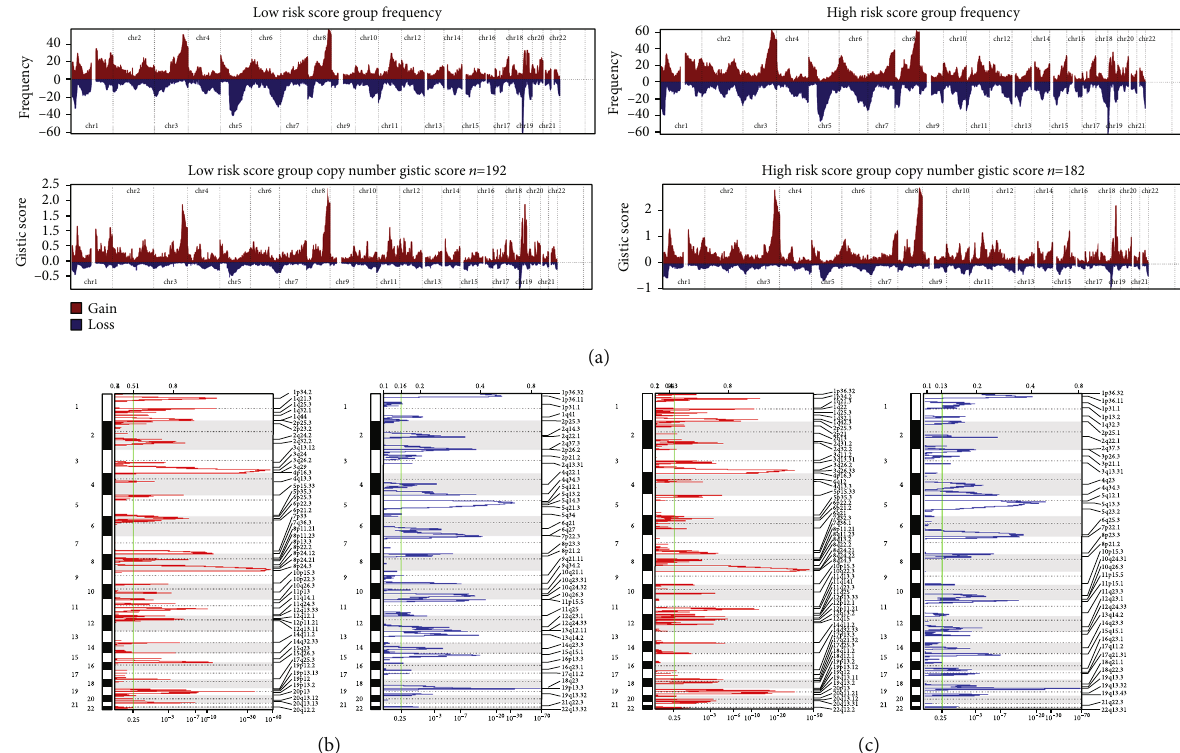
Figure 9: Copy number variation analysis. (a) Copy number pro fi les for low-risk and high-risk groups based on frequency and amplitude, with gains in red and losses in blue. Gene segments were placed according to their location on chromosomes, ranging from chromosome 1 to chromosome 22. (b) Regions of focal ampli fi cation (red) and focal deletion (blue) in the low-risk group were delineated by GISTIC2.0 software. (c) Regions of focal ampli fi cation (red) and focal deletion (blue) in the high-risk group were delineated by GISTIC2.0 software. q value (bottom) and G -score (Top) were listed as x -axis. The green line indicated the cuto ff value of the q value (0.25). Chromosome numbers were labeled on the left and regions with recurrent copy number variation that was labeled on the right of each